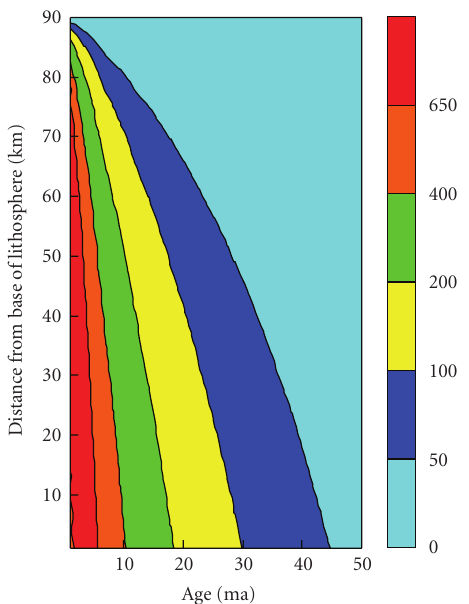
Figure 7: Vertical distribution of transient temperatures in the VBA model of the present work, for the parameter values listed in Table 1. The numbers on the curves are temperatures in degrees